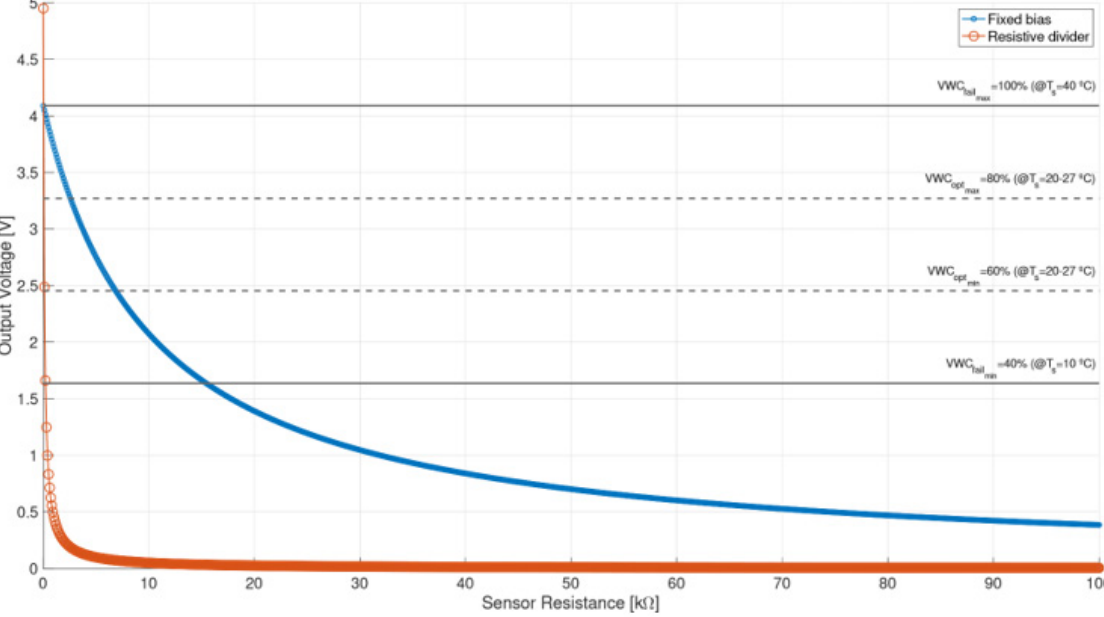
Figure 27. Output voltage (to the microcontroller) of the fixed bias and the resistive divider circuits, with the uncalibrated specified VWC.